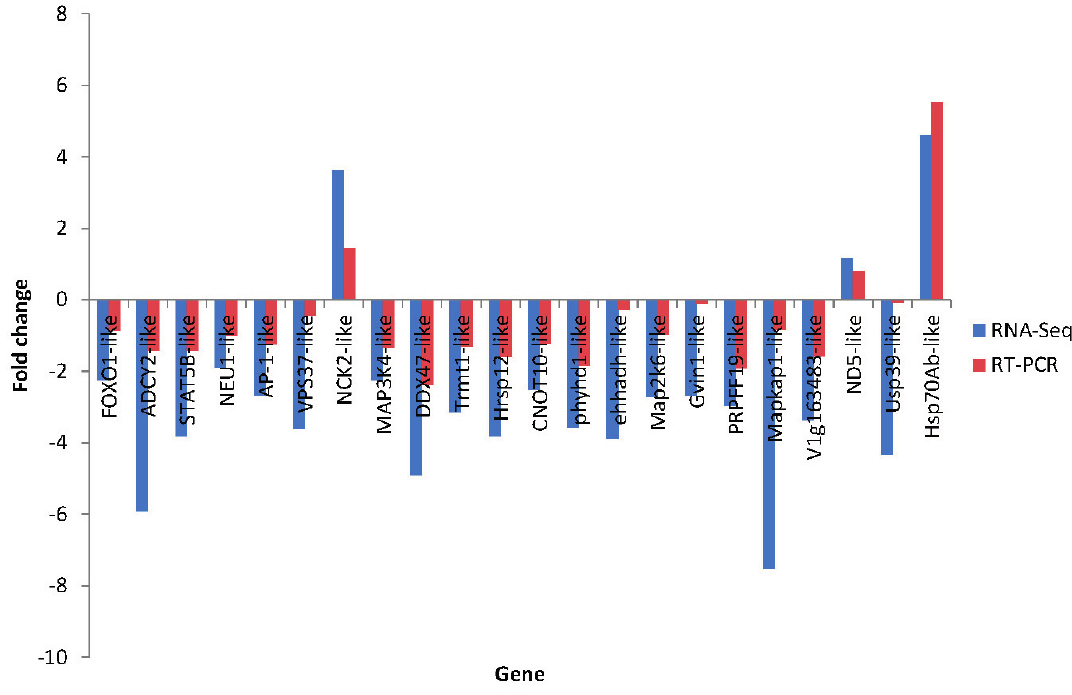
Figure 15. Comparison of 22 putative disease-resistant gene expression levels between RNA-Seq (blue bar) and RT-PCR (red bar). “ − ”indicates down-regulation.